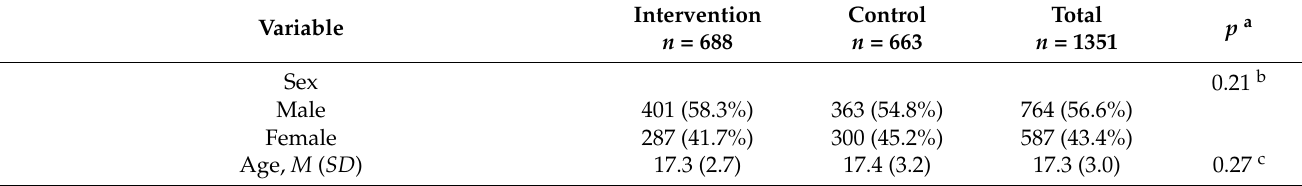
Table 1. Baseline characteristics of the study sample. Values represent n (%), unless stated